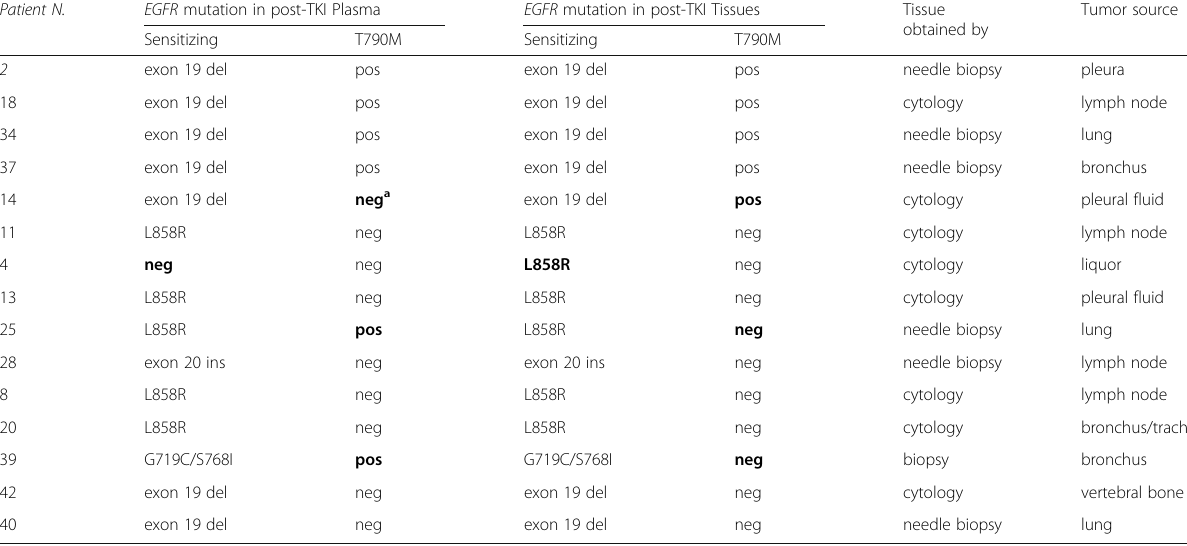
Table 2 Comparison of EGFR mutational status between plasma and post-TKI tissue samples Patient N.